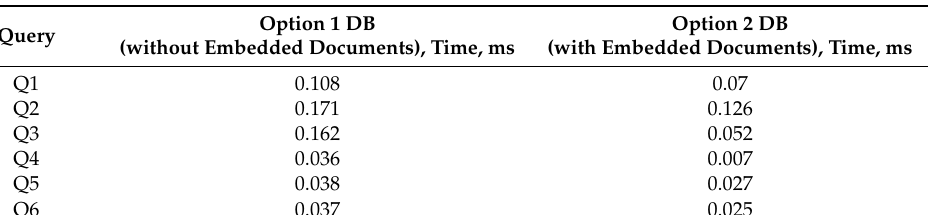
Table 2. The speed of execution of queries to document databases: without embedded documents and with embedded documents.